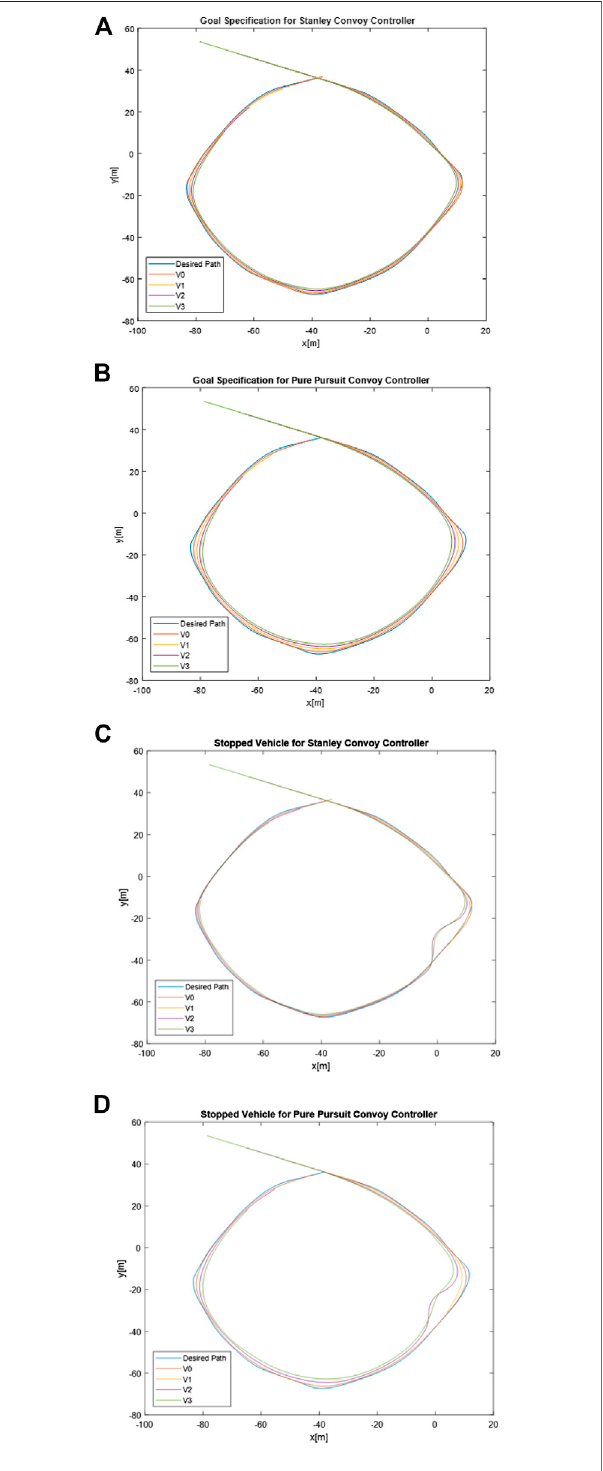
FIGURE 5 | Planned path and taken path of convoy vehicles for Requirement 1 using (A) Stanley and (B) Pure Pursuit and Requirement 6 using (C) Stanley and (D) Pure